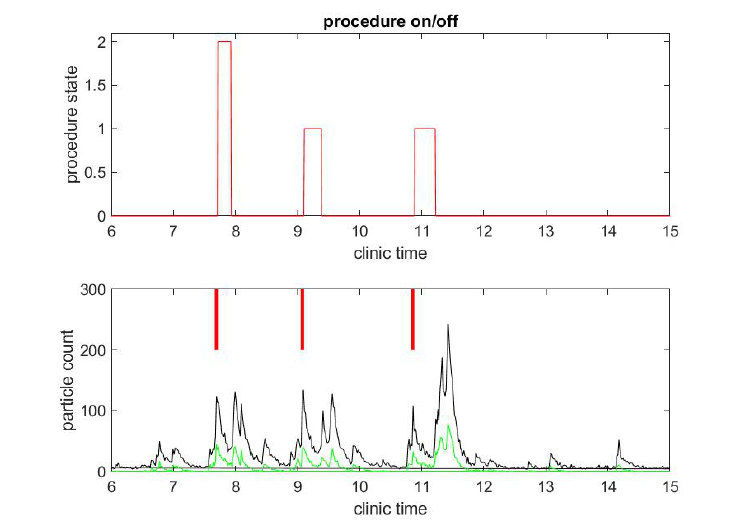
Figure 1. Example of particle counts during a clinical day in a procedural room. ( Top ) the procedure state, 1 for colonoscopy and 2 for EGD procedure; and ( Bottom ) small particle counts (black) and large particle counts (green), along with red bars for marking when the procedure from the upper graph